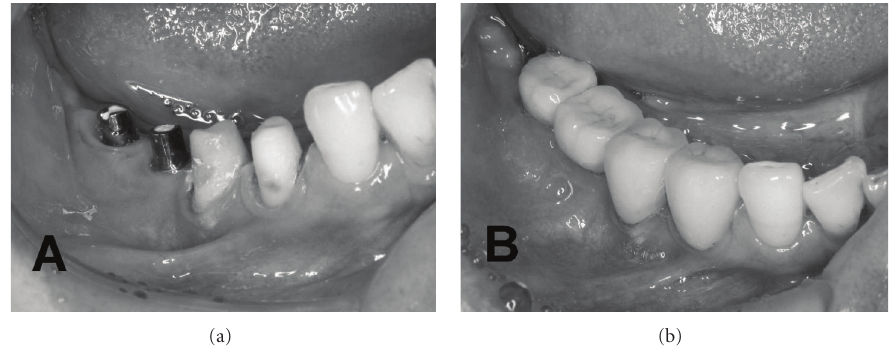
Figure 1: Porcelain has become the primary occlusal material for single-tooth and partial fixed implant